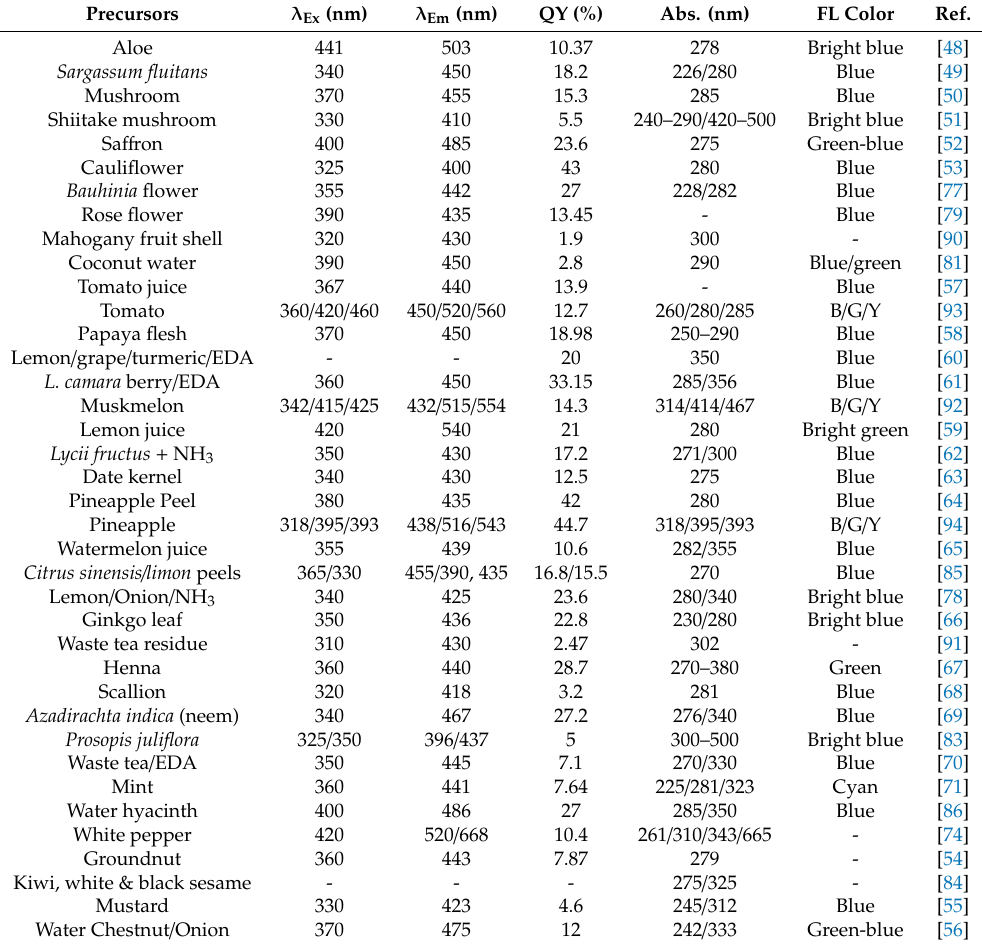
Table 3. The optical properties of plant part-derived CDs as biosensors. Abbreviations: λ Ex , excitation wavelength; λ Em , emission wavelength; QY, quantum yield, Abs, absorbance; B / G / Y, blue / green /